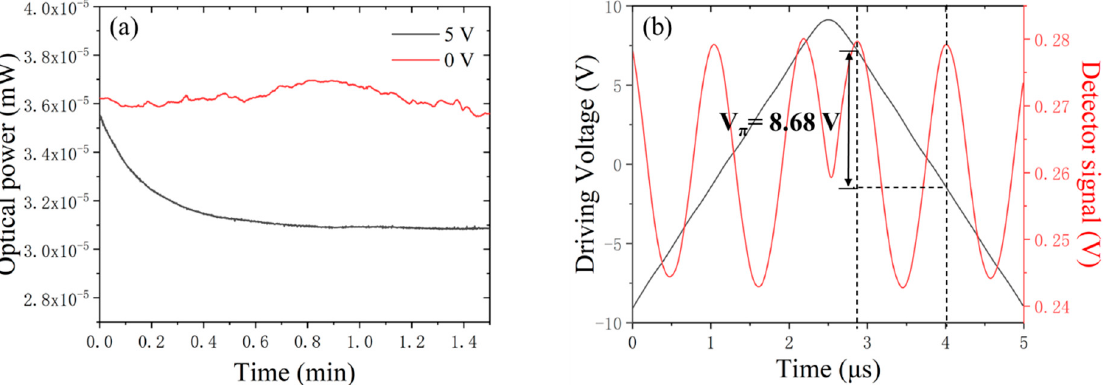
Figure 8. Electric field E z ( a ) and E x ( c ) distributions of the TE 00 mode. Electric field E z ( b ) and elec- tric field E x ( d ) distributions of the electrostatic field after 1 V voltage was applied to the elec- trodes.